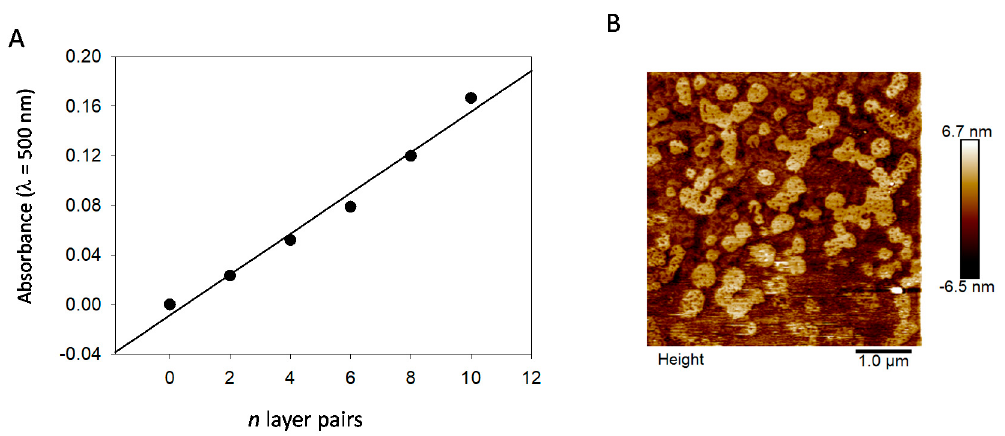
Figure 9. Incorporation of PDA@ALP nanoparticles in layer-by-layer films. ( A ) Evolution of the absorbance at λ = 500 nm (where PAH does not absorb light) of (PAH-PDA@ALP) n films with the number of deposited layer pairs, n . ( B ) Film morphology of a (PAH-PDA@ALP) 6 film as investigated by means of contact mode AFM.